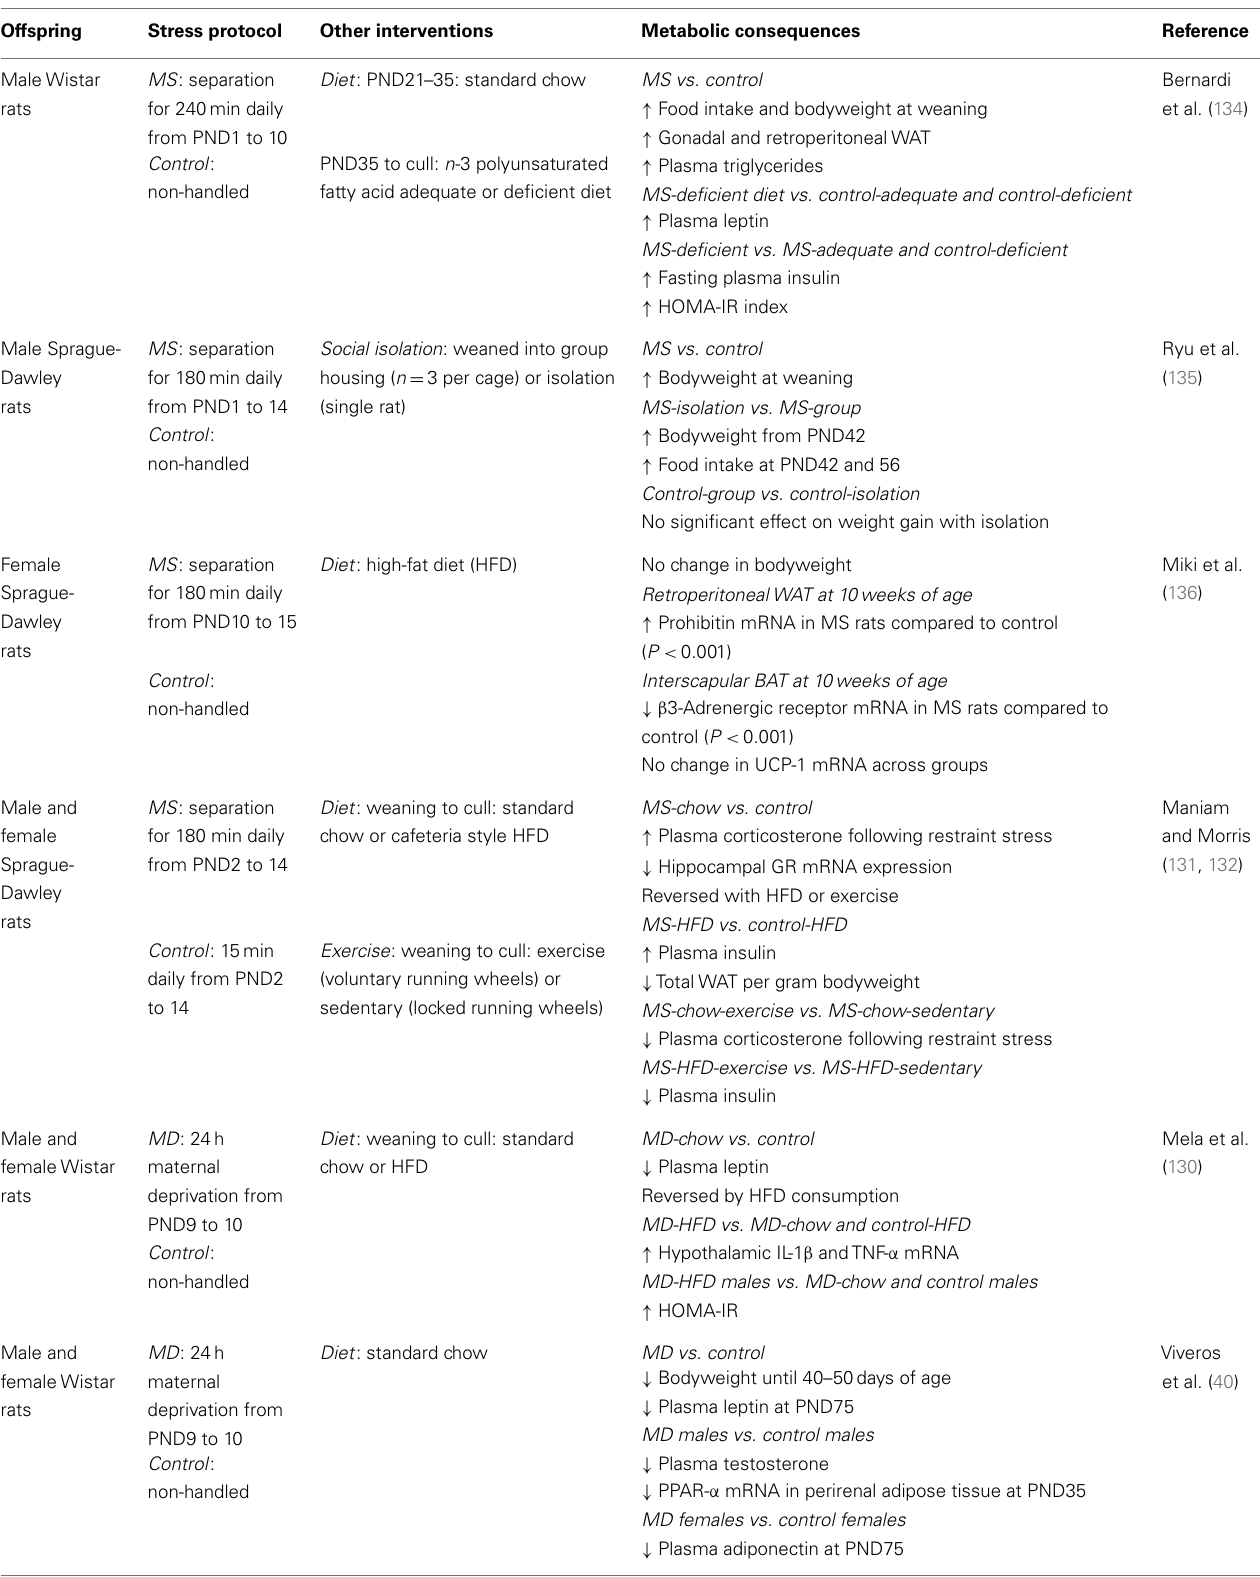
Table 2 | Postnatal early-life stress and metabolic consequences in rodents . Offspring Stress protocol Other interventions Metabolic consequences